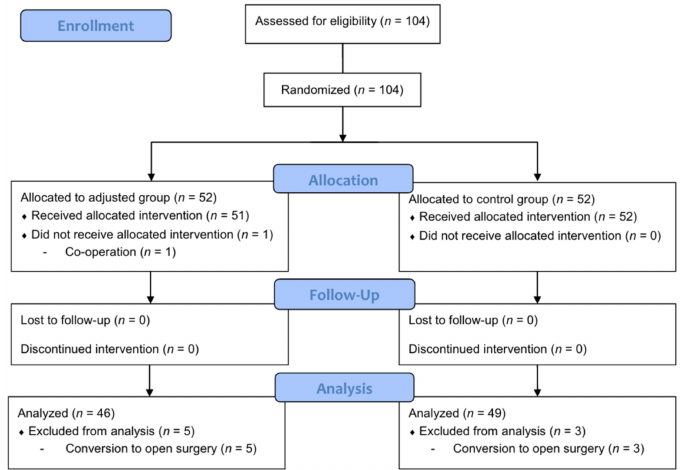
Figure 2. CONSORT diagram for the trial. One hundred four patients were randomized and 9 patients were excluded from the final analysis. Finally, a total of 95 patients (46 in the adjusted group, and 49 in the control group) were